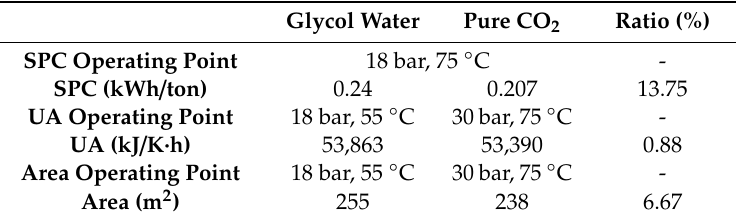
Figure 11. Changes in the area as a function of temperature in each group when using CO 2 as the heat medium. Table 5. Optimal operating point results.